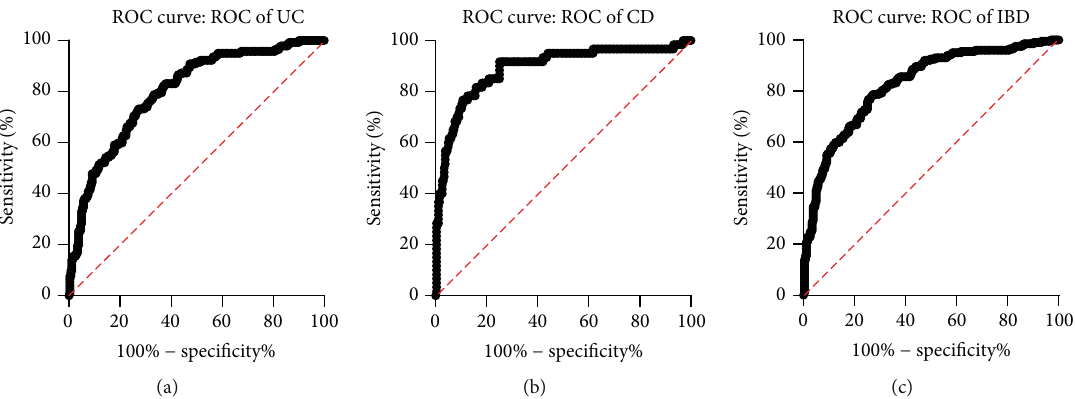
Figure 5: (a) ROC curve of serum ChE for UC patients. (b) ROC curve of serum ChE for CD patients. (c) ROC curve of serum ChE for IBD